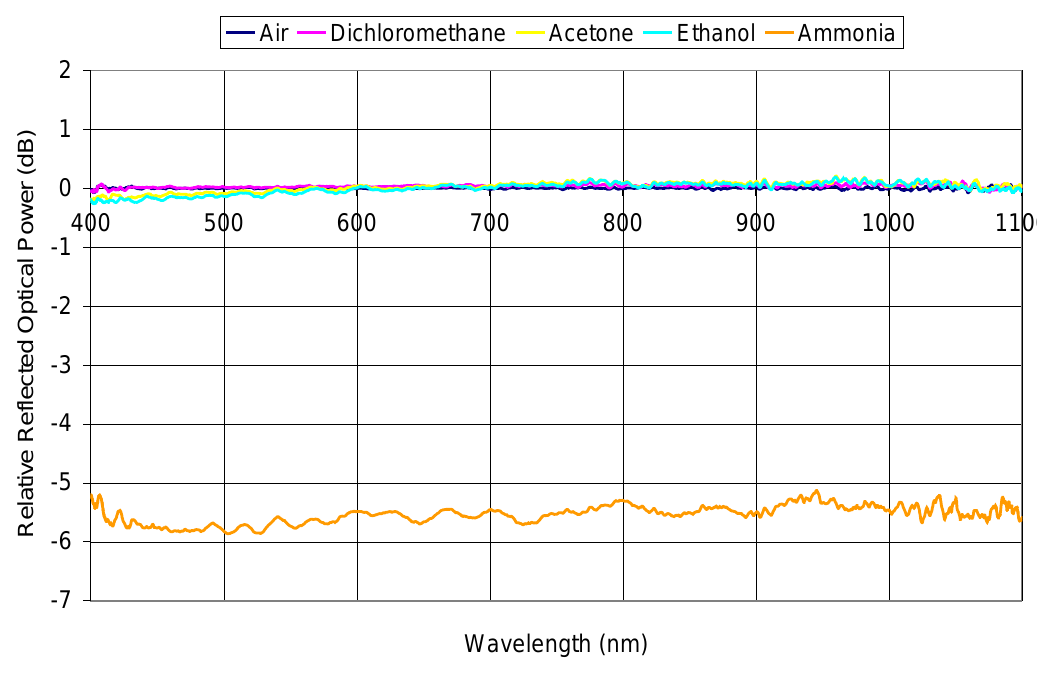
Figure 22 . Spectral response of an ammonia sensor based on nanostructurated Zirconia films [85]. A negligible variation of the reflected optical power is registered in the presence of other